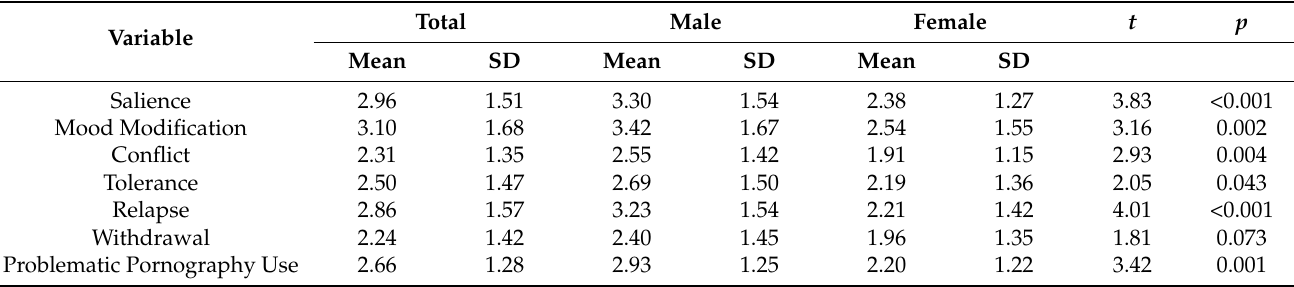
Table 2. Gender differences in problematic IPU ( n = 144).